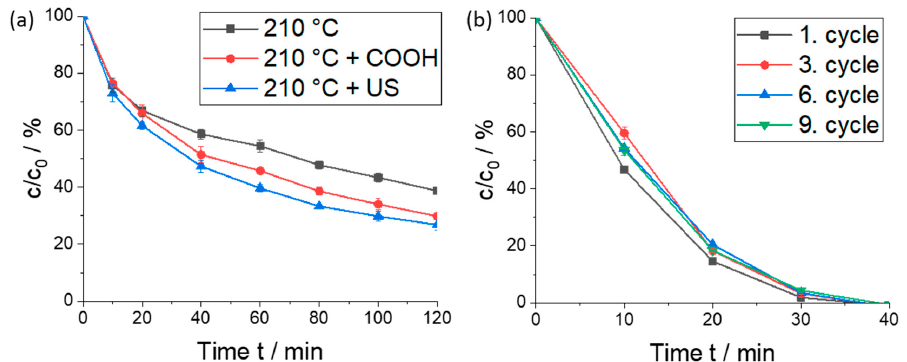
Figure 8. ( a ) Photocatalytic degradation of carbamazepine (25 mg L − 1 ) over time for PES